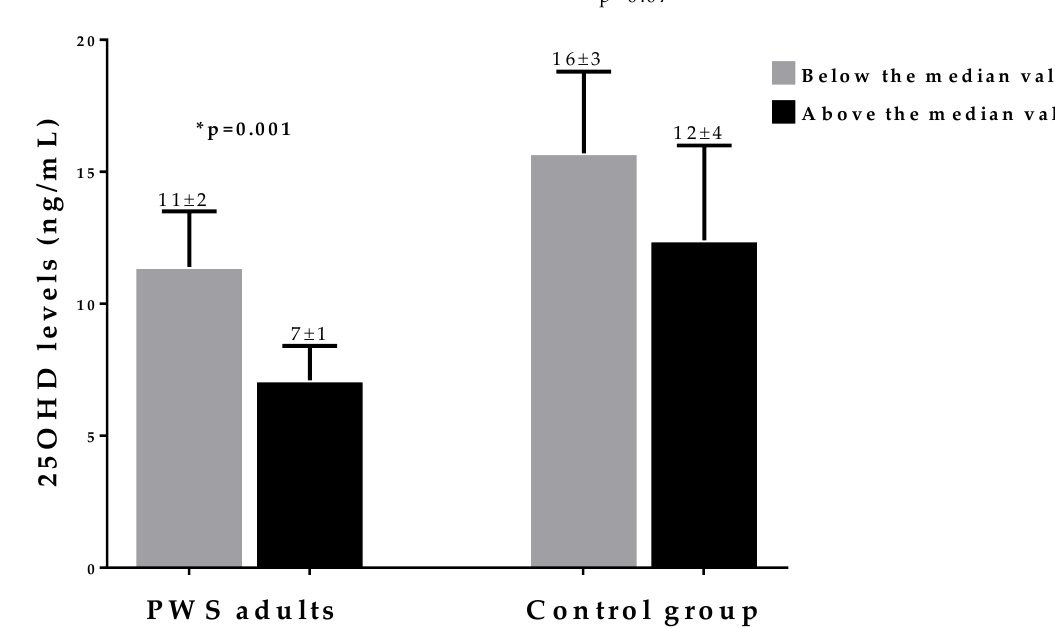
Figure 3. Differences in 25OHD levels in PWS adults and in the control group within fat mass categories (above and below the median values). Fat mass median values were 46 and 58 Kg in PWS adults and the control group, respectively. The 25OHD levels were lower in the fat mass category above the median values in PWS adults only (11 ± 2 vs 7 ± 1; p = 0.001). * A p value < 0.05 means a significant difference. PWS, Prader–Willi syndrome.